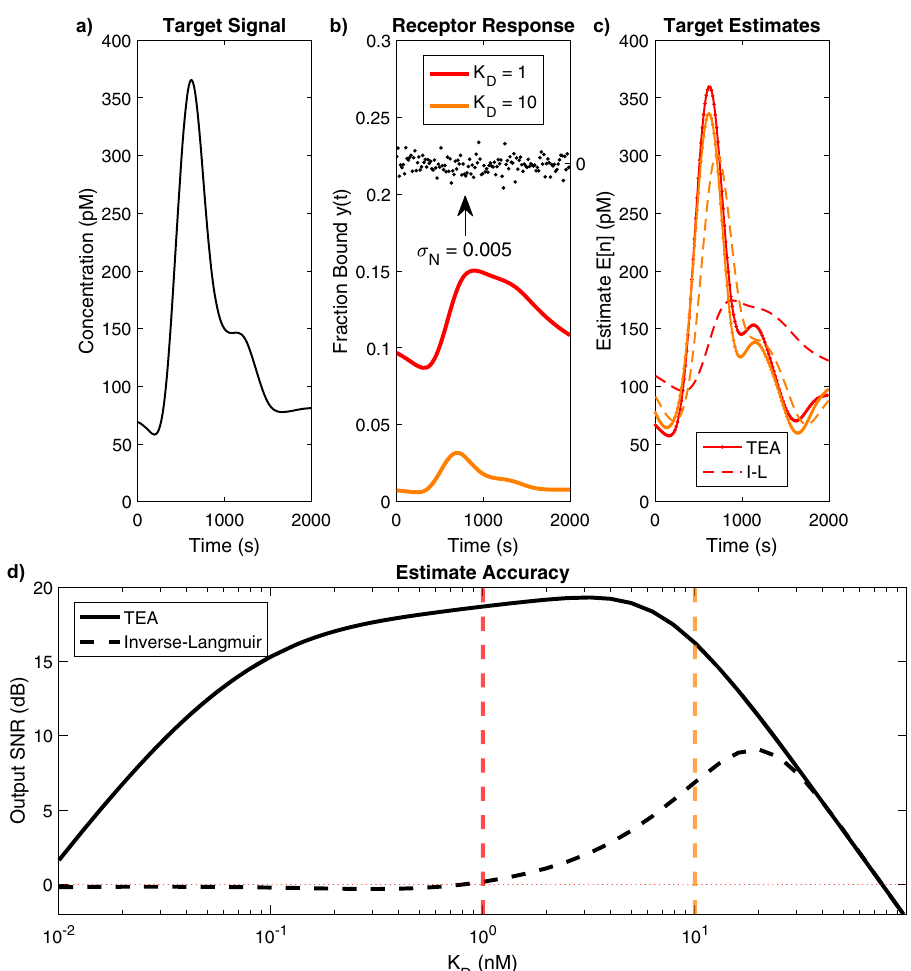
Fig.9|Asimulationoftheimpactof K D optimizationusingTEAversusinverse- Langmuir. a Target concentration T ( t ) used in this simulation. b Simulated response of two receptors with fi xed k on =10 6 s − 1 M − 1 but different K D s to a spikein target concentration. Also shown for comparison is the noise N [ n ] introduced by the detector system (black dots). In this simulation, N [ n ] is zero-mean white noise withastandarddeviationof0.005fractionbound. c Theresponseofthereceptors was sampled at f S =1/15Hz and the noisy samples were digitally low-pass fi ltered with f T =1/400Hz. The data was then used to reconstruct the original target